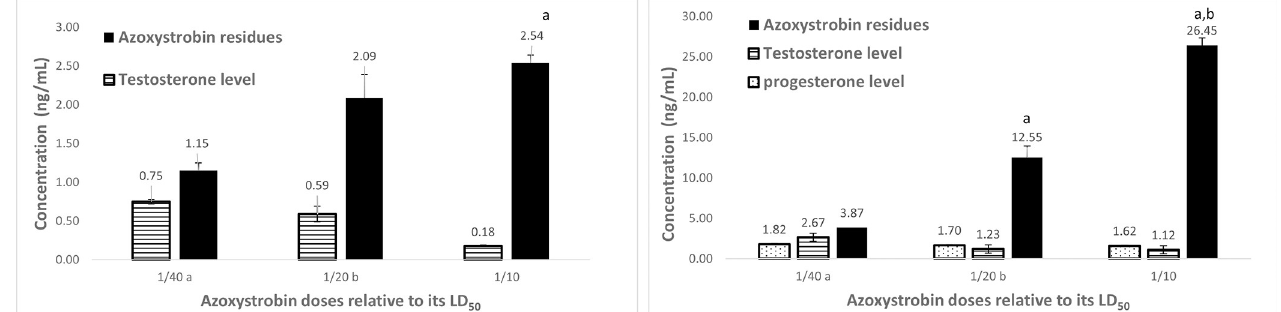
Fig 7. A. Serum testosterone levels and azoxystrobin residues after a month of different azoxystrobin doses treatment of male rats. Data presented as mean S.E. a Significant difference as compared to 1/40 LD b significant difference as compared to 1/20 of LD 50 , and 50 (n = 4, P � 0.05). B. Serum testosterone and progesterone levels as well as azoxystrobin residues after 2 months of different azoxystrobin doses treatment on male rats. Data presented as mean S.E. a Significant difference as compared to 1/40 LD 50 , and b significant difference as compared to 1/20 of LD 50 (n = 4, P � 0.05).